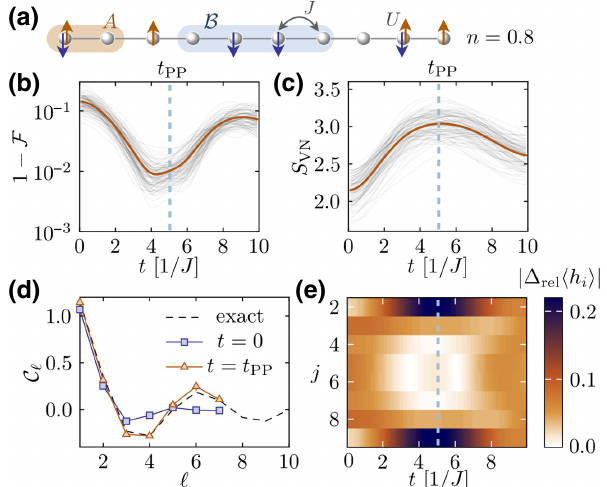
FIG. 10. Purification preparation for a ten-site Hubbard model with U / J = 2 and 40% filling ( n = 0.8). (a) Sketch of the Fermi- Hubbard chain with n = 0.8. (b) Fidelity [Eq. (10)] computed between a bulk subsystem ( B ) of the ten-site chain and a cor- responding subsystem in the ground state of a 200-site chain, during time evolution with the deformed Hamiltonian. The gray lines show the results for 100 different random superpositions for the initial state (see main text). The bold solid line represents the mean over all experiments for different initial states. (c) Analo- gous plot to (b) for the von Neumann entanglement entropy of the subsystem A indicated in (a). (d) Decay of the two-point corre- (cid:2) in the lation function C (cid:18) = 1 /( N B − (cid:18)) i , σ initial state and in the state at the optimal time t PP . The black dashed line shows the decay of correlations in the ground state of FIG. 11. (a) Scheme to design the Trotterized evolution from a 200-site chain. (e) Absolute value of relative difference between the deformation given by the blue solid curve, see the text. (b) local energy densities (see main text) for a six-site bulk of the Trotterized PP of the N = 36 1D system of free fermions starting chain as a function of time. from the OBC GS. Trotterizations with ˜ n min = 2 (solid lines) and = 8 (dashed lines) are given. The orange and green lines ˜ n min show the infidelity and the red lines give the Rényi entropy S ( 2 ) obtained on the two most left